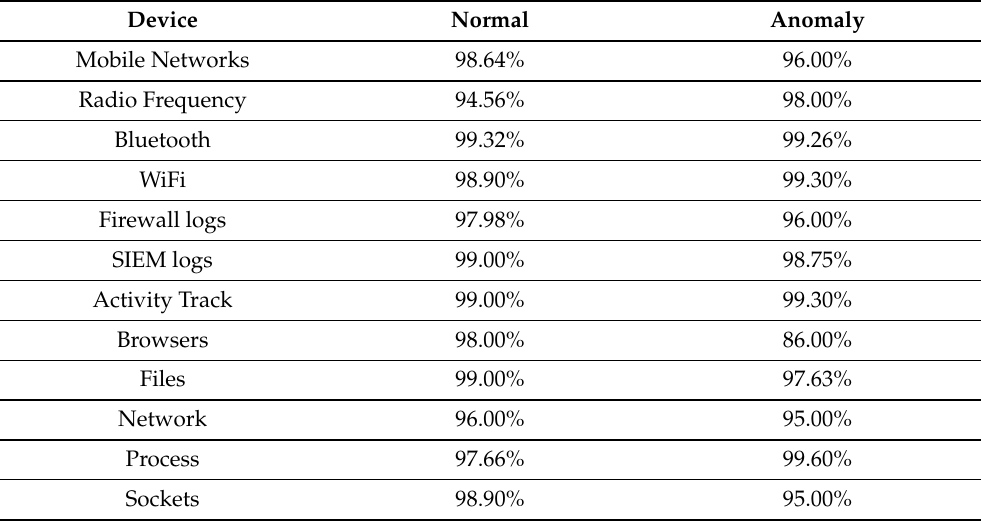
Table 4. Accuracy in